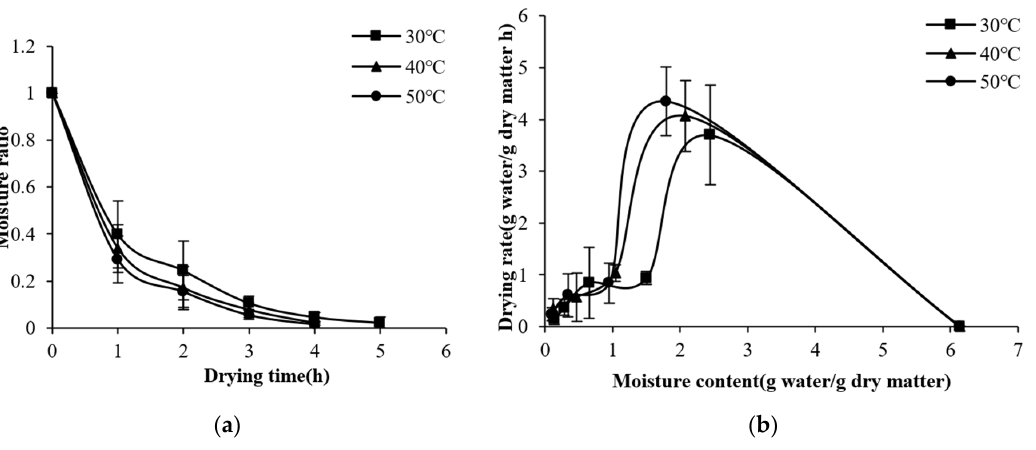
Figure 4. Moisture ratio ( a ) and drying rate ( b ) of kelp HP at different drying temperatures.